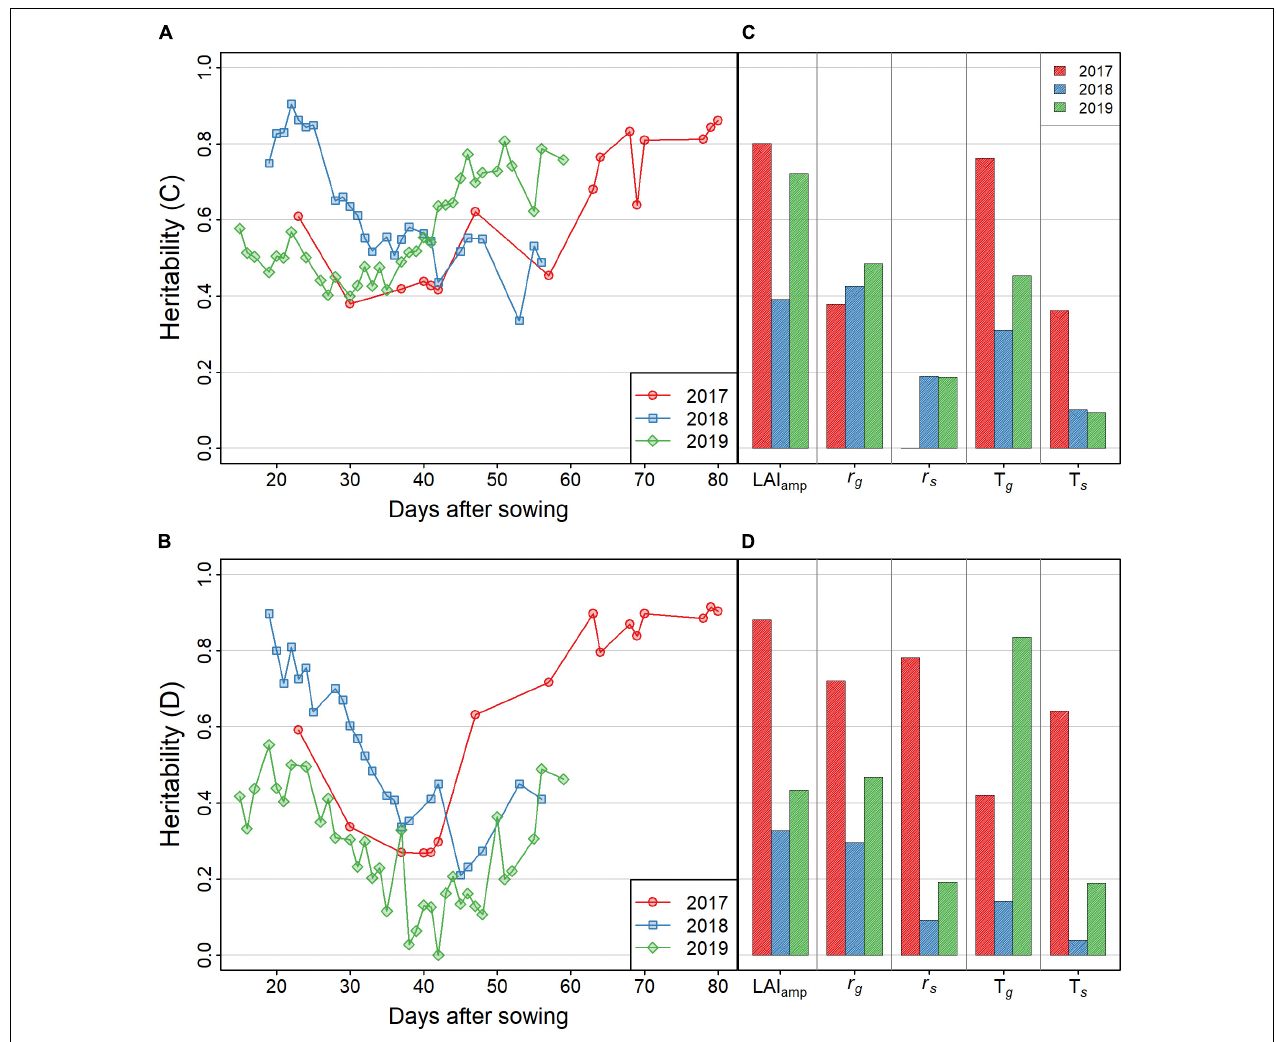
FIGURE 5 | (A,B) Heritability of the GF. Results of treatments C and D are shown in (A,B) , respectively. Red, blue, and green lines indicate the values in 2017, 2018, and 2019, respectively. (C,D) Heritability of the LAI dynamics model parameters. Results of treatments C and D are shown in (C,D) ,